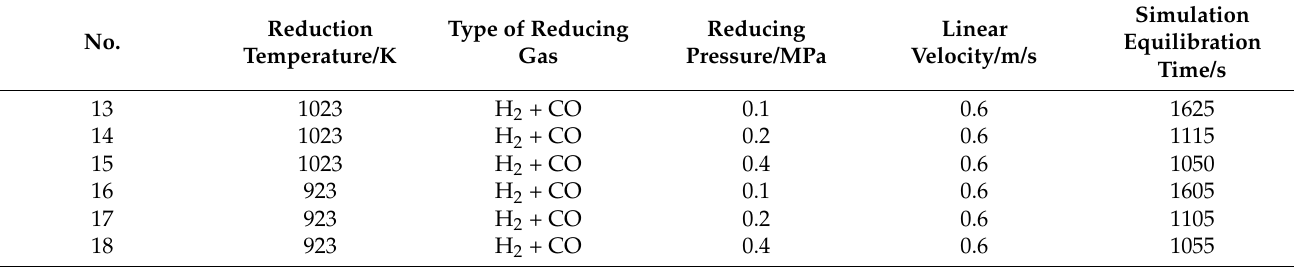
Table 8. Experimental scheme and